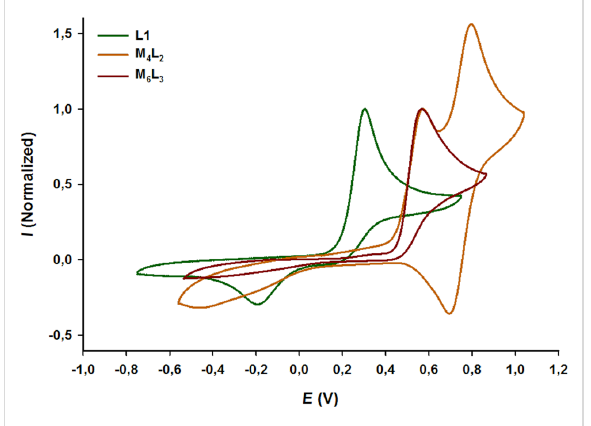
Figure 5: Cyclic voltammogram of L1 ( c = 10 − 3 M, CH 3 CN/CH 2 Cl 2 (v/v 50/50), 0.1 M n -Bu 4 NPF 6 , 100 mV·s − 1 , Pt), M 4 L 2 and M 6 L 3 ( c = 10 − 3 M, CH 3 CN, 0.1 M n- Bu 4 NPF 6 , 100 mV·s − 1 , Cgr), V vs Fc/Fc +